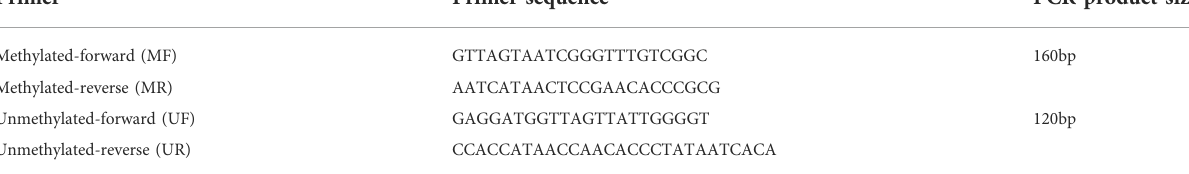
TABLE 1 MS-PCR primers and PCR product size.